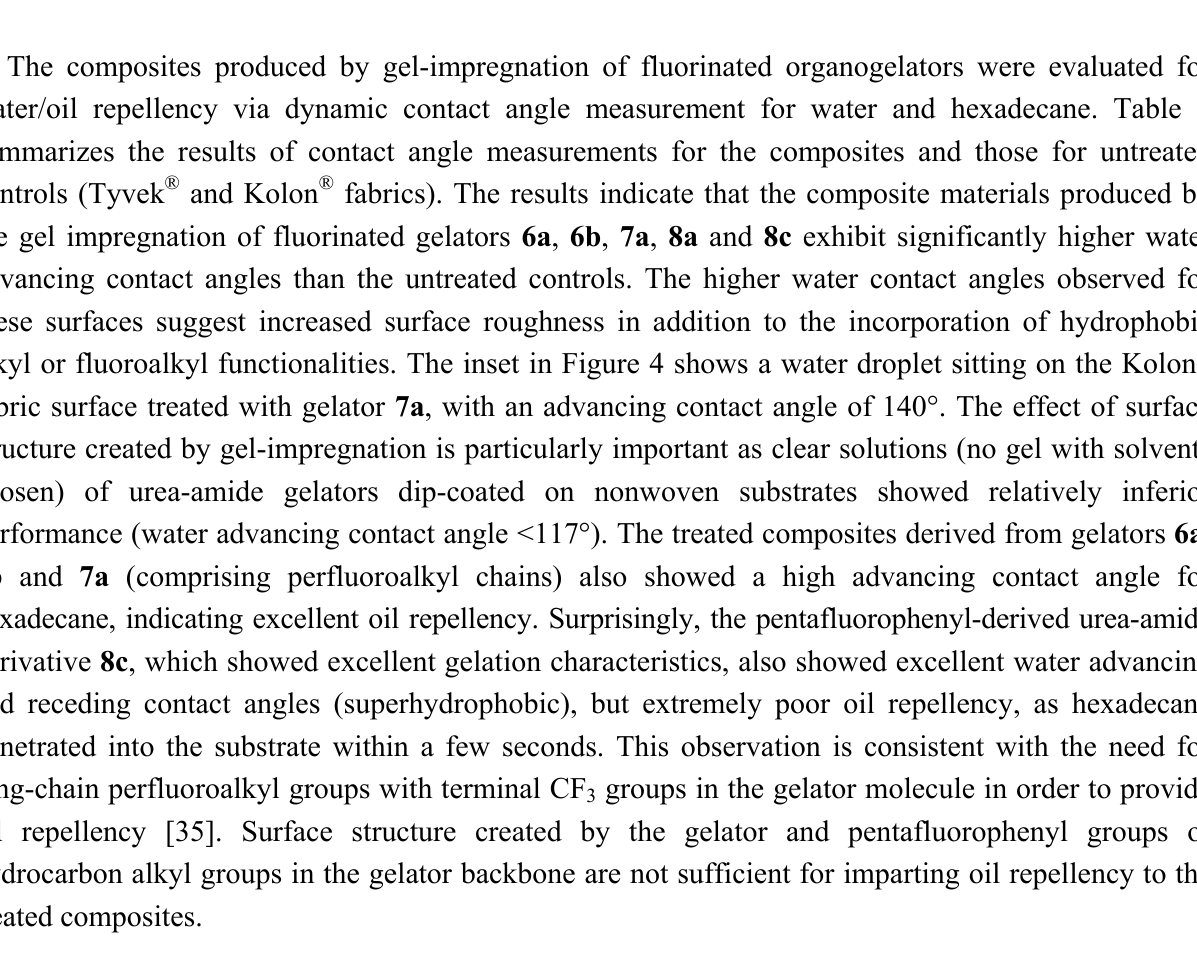
Table 2. Water and hexadecane contact angles of treated nonwoven composites prepared via gelation in organic solvents